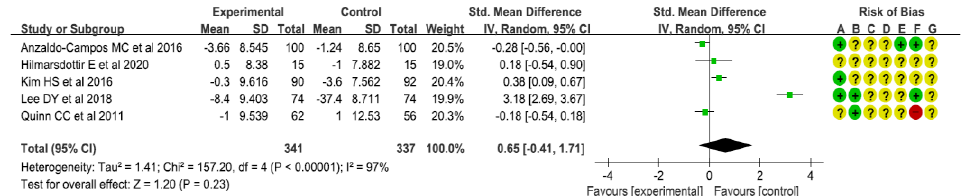
Figure 11. Forest plot for meta-analysis results on diastolic blood pressure.